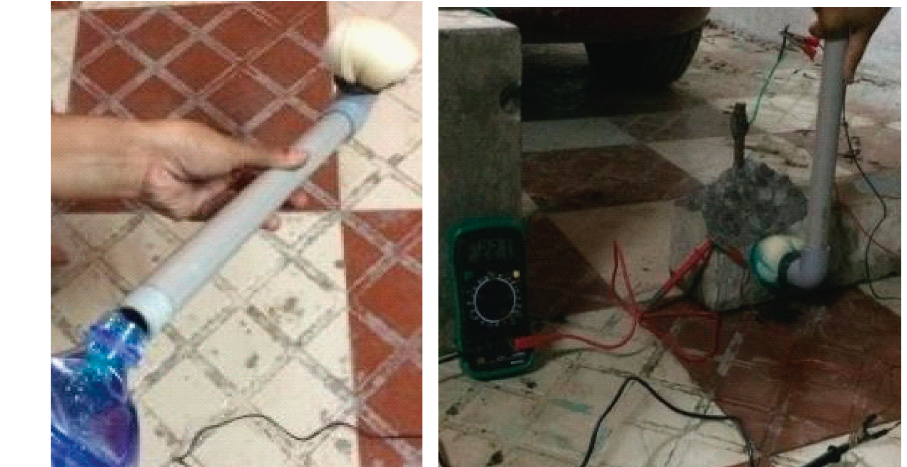
Figure 6: Half-cell potential measurements.